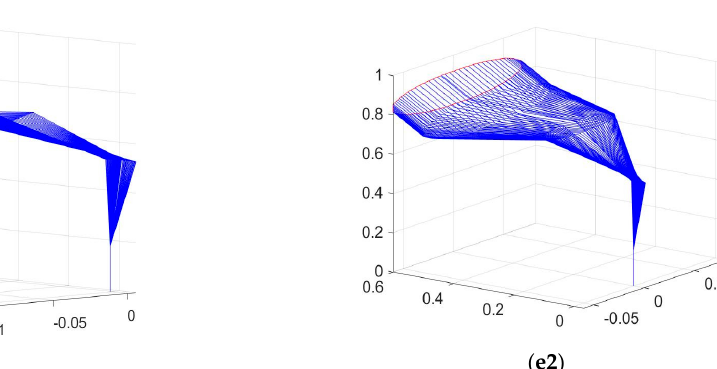
Figure 7. Simulations of the trajectory planning by PI-HGSO under lines and curves. ( a1 ) Joint angles under line; ( a2 ) Joint angles under curve; ( b1 ) Joint velocities under line; ( b2 ) Joint velocities under curve; ( c1 ) Error in x, y, and z under line; ( c2 ) Error in x, y, and z under curve; ( d1 ) Error of end-effector under line; ( d2 ) Error of end-effector under curve; ( e1 ) Motion trajectories under line; ( e2 ) Motion trajectories under curve. Table 3. The comparative results of PI-HGSO and other algorithms. The Value and Percent of